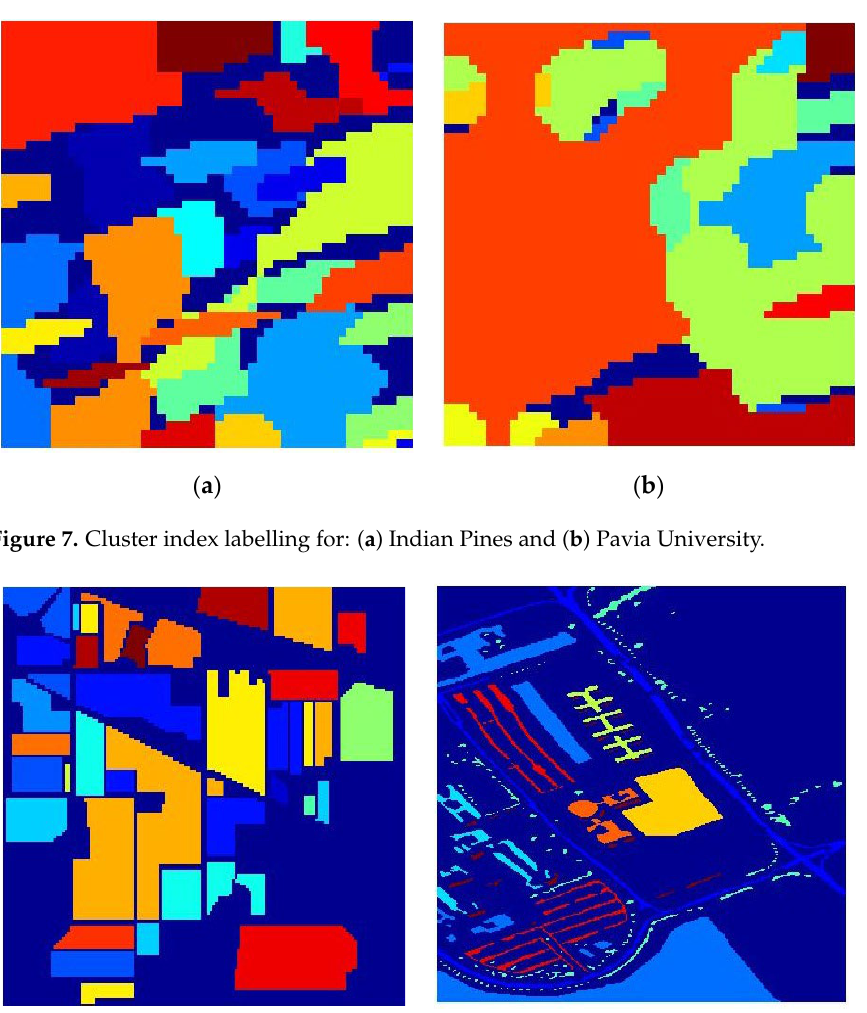
Table 2. Number of labeled samples and information classes (Pavia University).